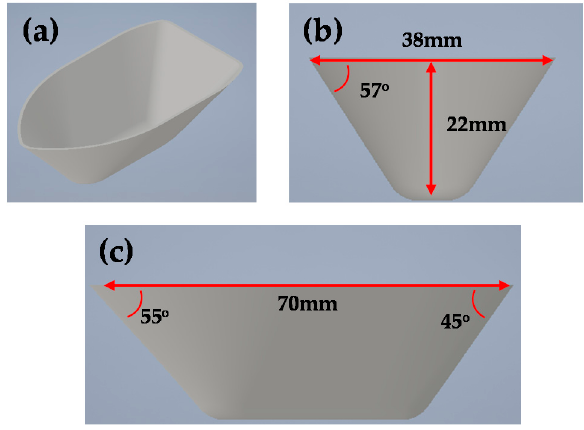
Figure 16. CAD design of the ship-hull shape with ( a ) isometric, ( b ) front, and ( c ) side views.